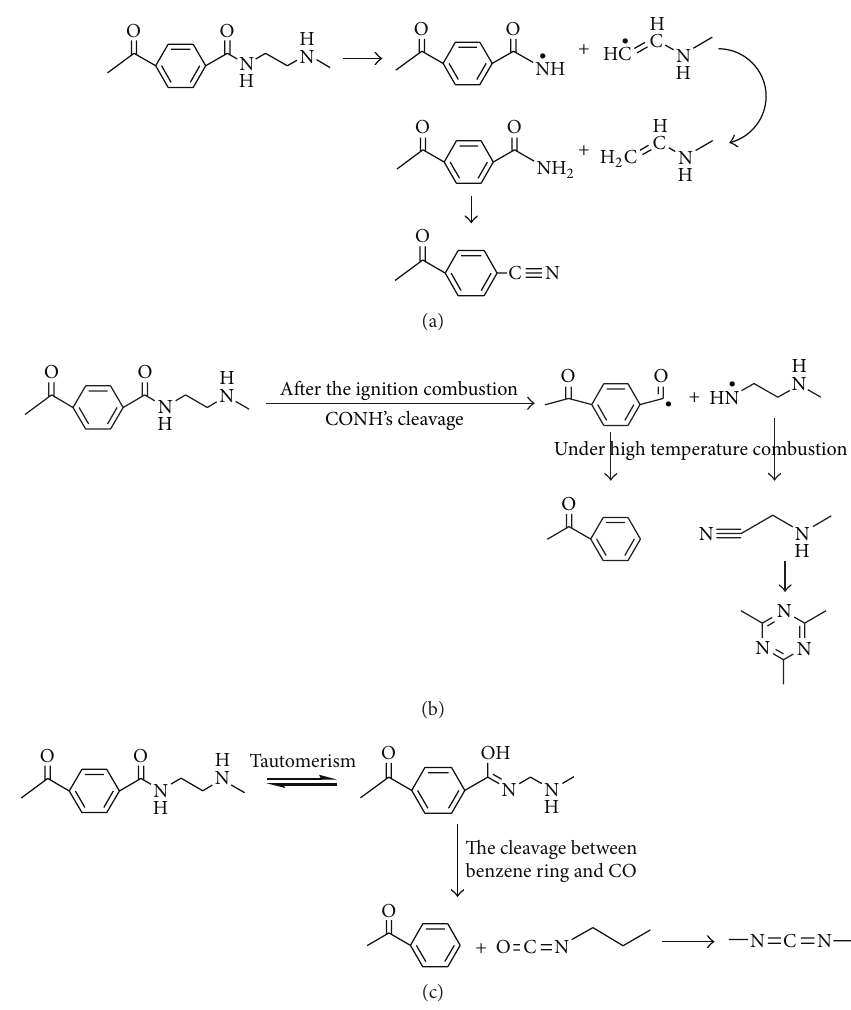
Figure 8: Formulas of the degradation mechanism of PETA (a) and the IFR material (b),